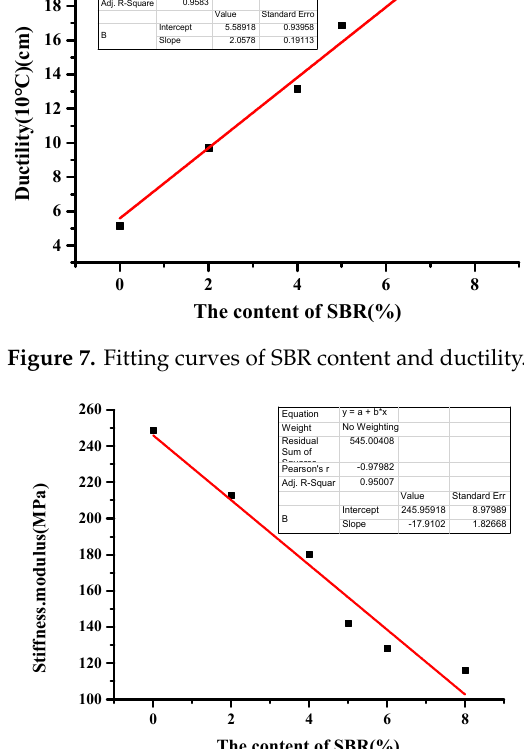
Figure 8. Fitting curves of SBR content and stiffness modulus.